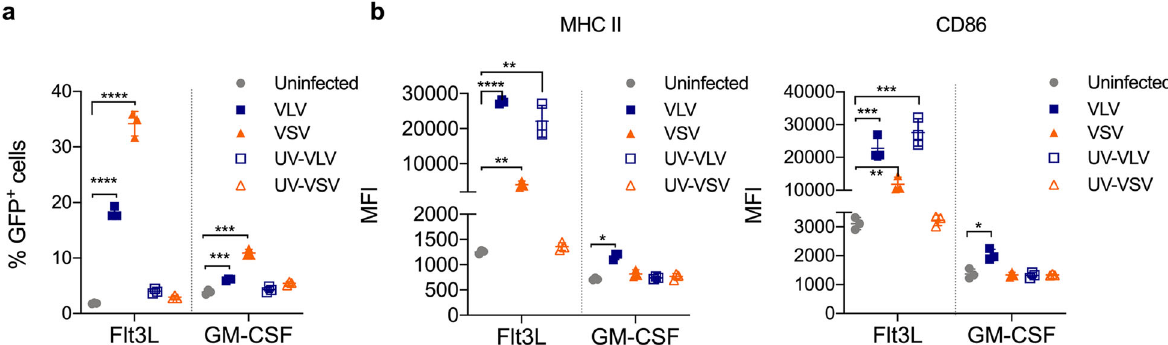
Fig. 6 Viral replication is not required for activation of Flt3L-derived BMDCs. Eighteen hours after infection of Flt3L and GM-CSF BMDCs with either VLV, VSV, or UV-inactivated VLV or VSV (MOI 10), cells were analyzed by fl ow cytometry. a Percentage of GFP + cells. b MHC II and CD86 expression 18 h after infection of Flt3L- or GM-CSF-derived DCs. Data are expressed as mean ± standard deviation. * p < 0.05, ** p < 0.01, *** p < 0.001, **** p < 0.0001 compared to uninfected control by multiple t -test or one-way